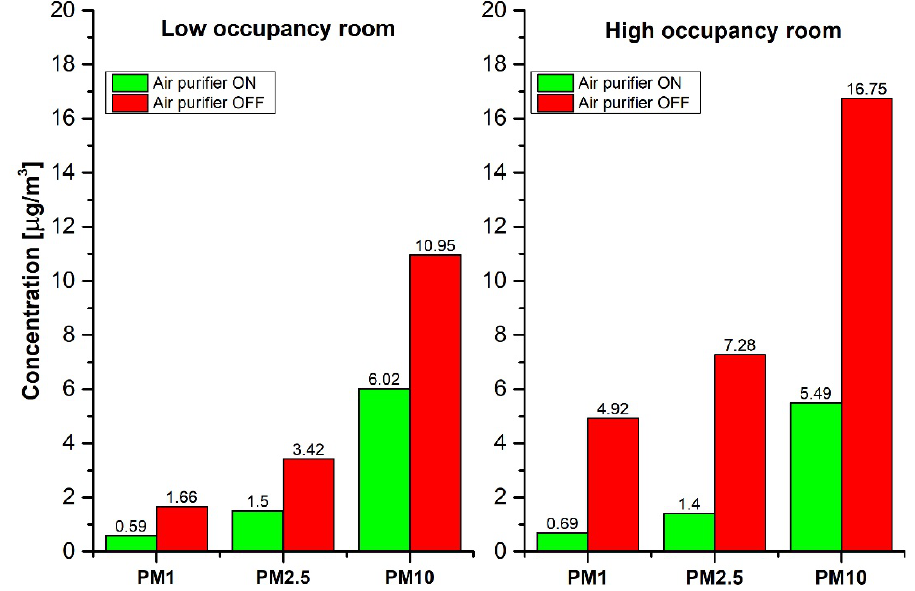
Figure 10. The mean PM concentrations recorded with OPC-N3 in the low- and high-occupancy rooms when the air purifier was operating or not. The correlations were statistically significant at the 95% confidence level.